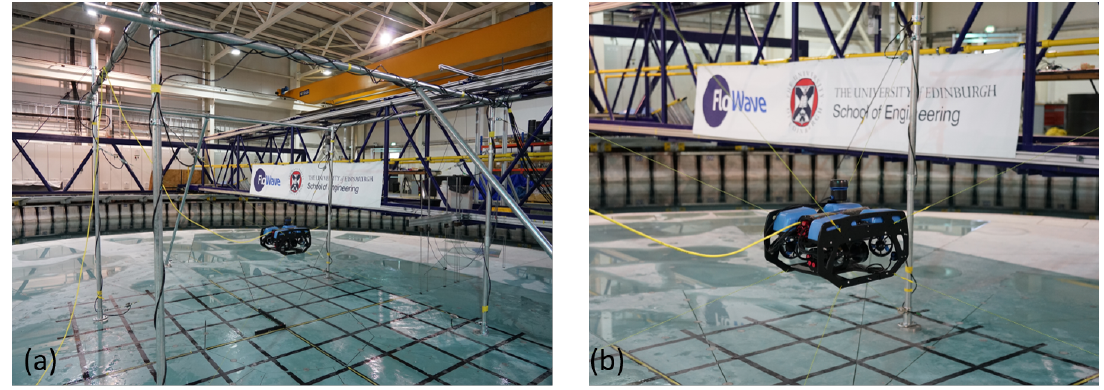
Figure 7. ( a ) Set up of the experiment in the FloWave circular tank; ( b ) Tethers equipped with load cells attached to the